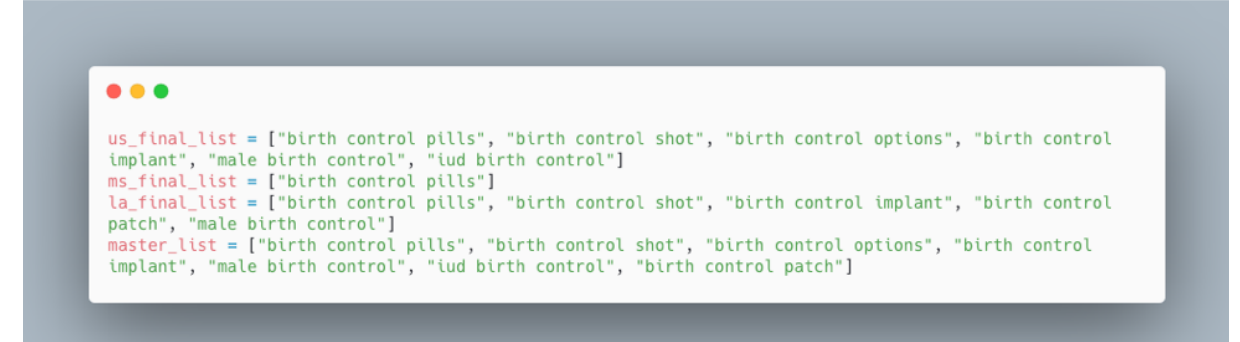
Figure 1. Creation of a master list as visualized in Python for birth control in the United States, Mississippi, and Louisiana in